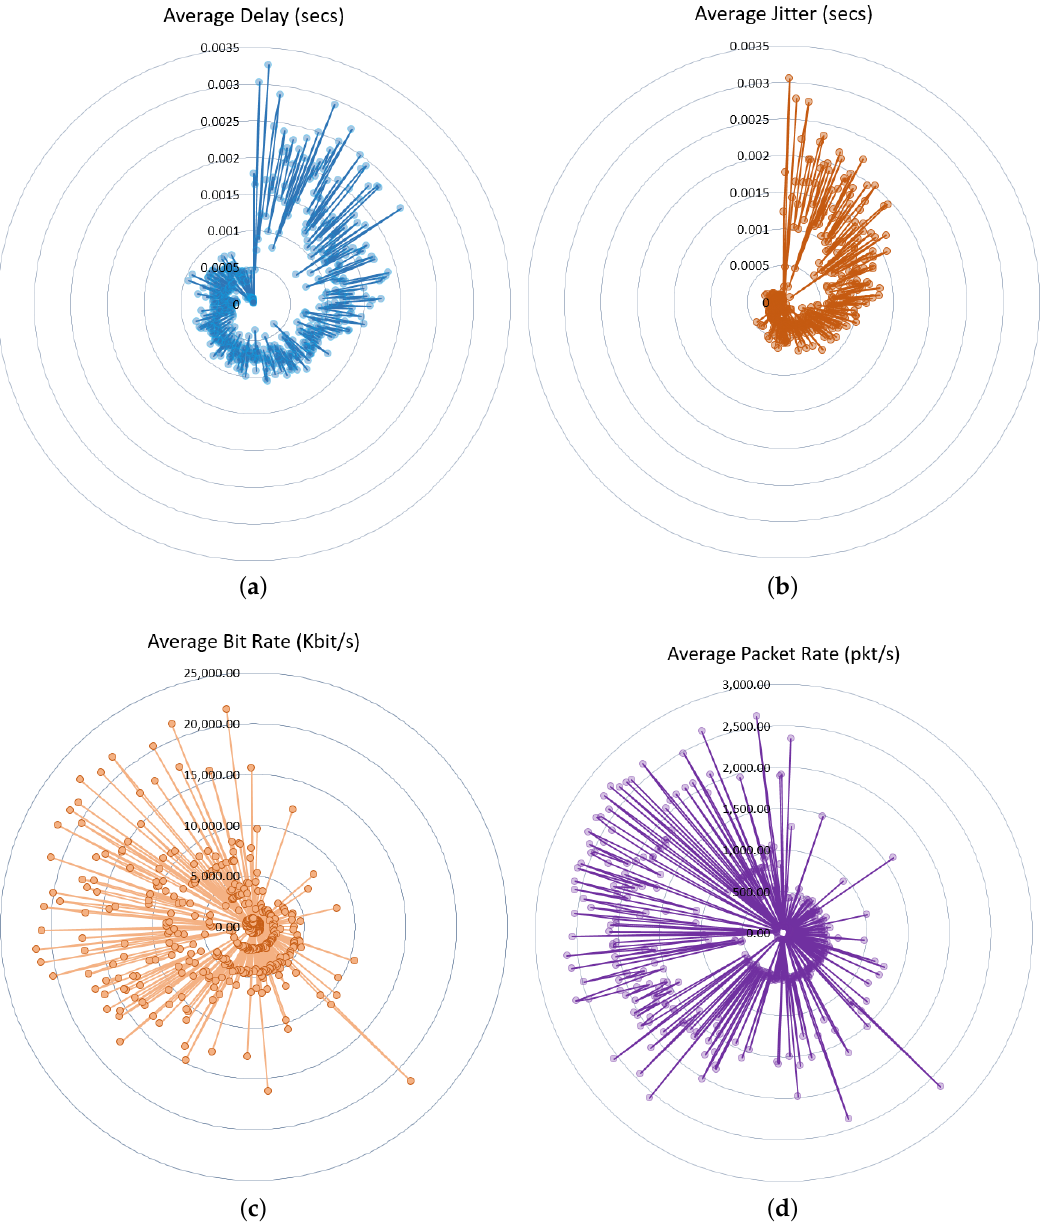
Figure 6. Distribution range of sample dataset (507 samples), ( a ) Data samples for average delay, ( b ) Data samples for average jitter, ( c ) Data samples for average bit rate, ( d ) Data samples for average packet